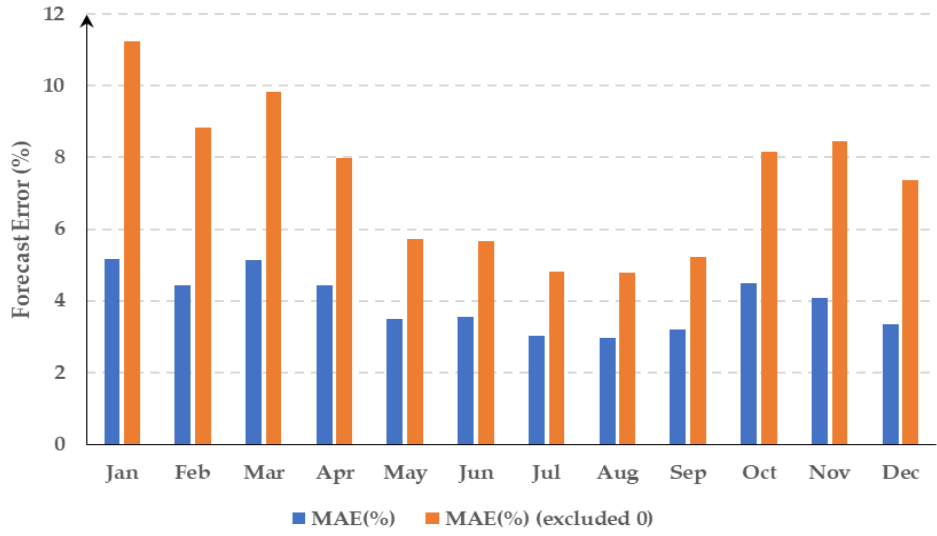
Figure 10. Forecast error for solar power output in 2016.